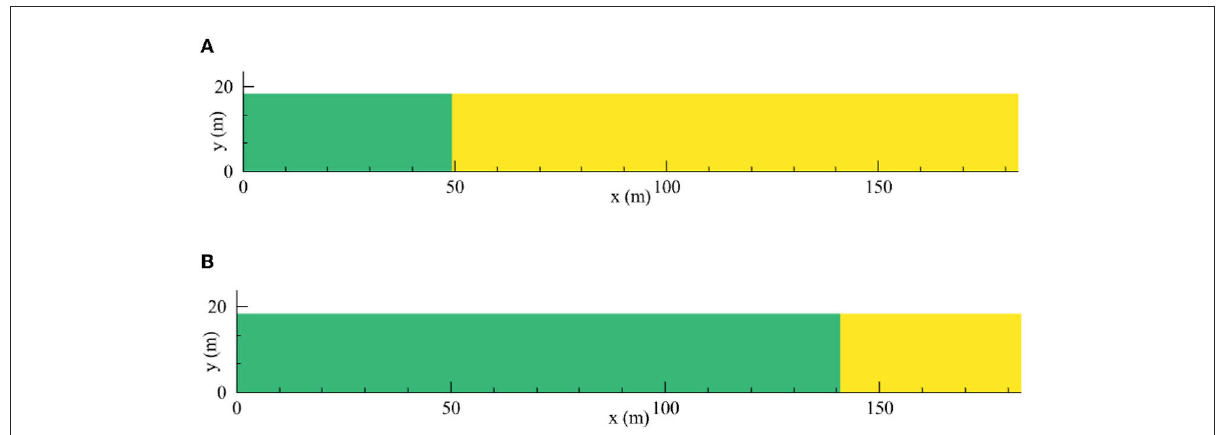
FIGURE6 The position of coupling boundary at different times. (A) t = 1,800s. (B) t =